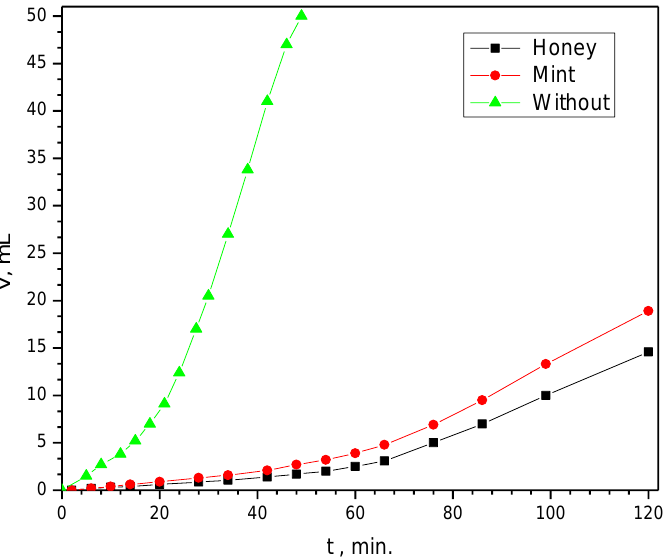
Figure 5. Hydrogen evolution during the Aluminum corrosion in 1 M HCl in the absence and the presence of 900 ppm of inhibitors. Table 5. Percentage IE and surface coverage ( θ ) values acquired, using the hydrogen–evolution approach in the presence of the inhibitors in 1 M HCl. The standard deviation is shown by the ( ± ) sign, and these numbers represent the average of three measurements.